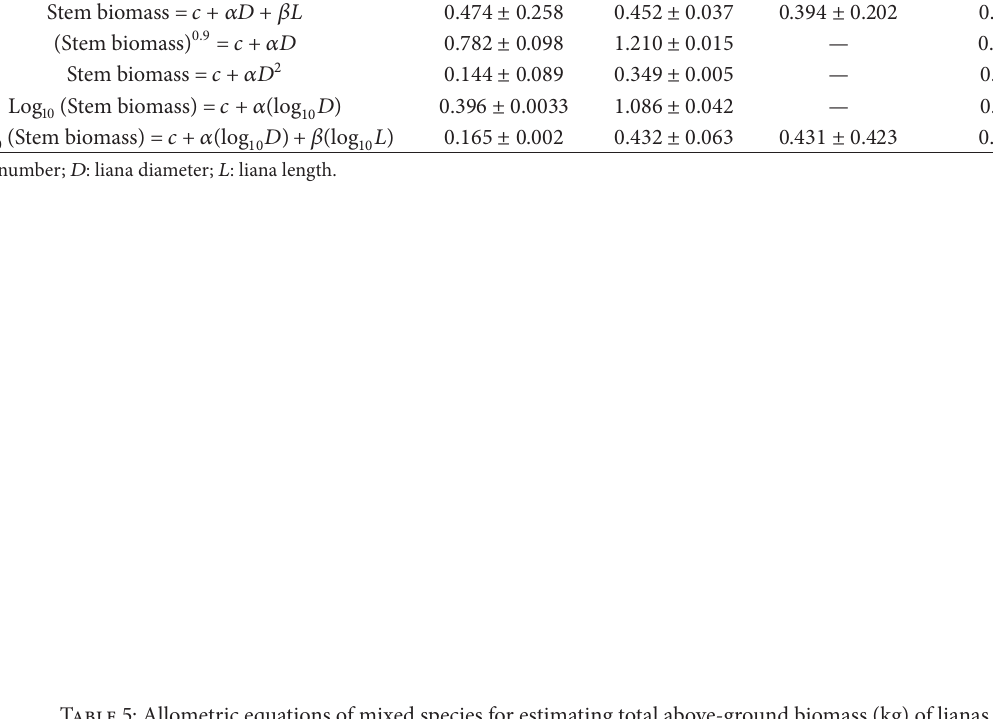
Table 5: Allometric equations of mixed species for estimating total above-ground biomass (kg) of